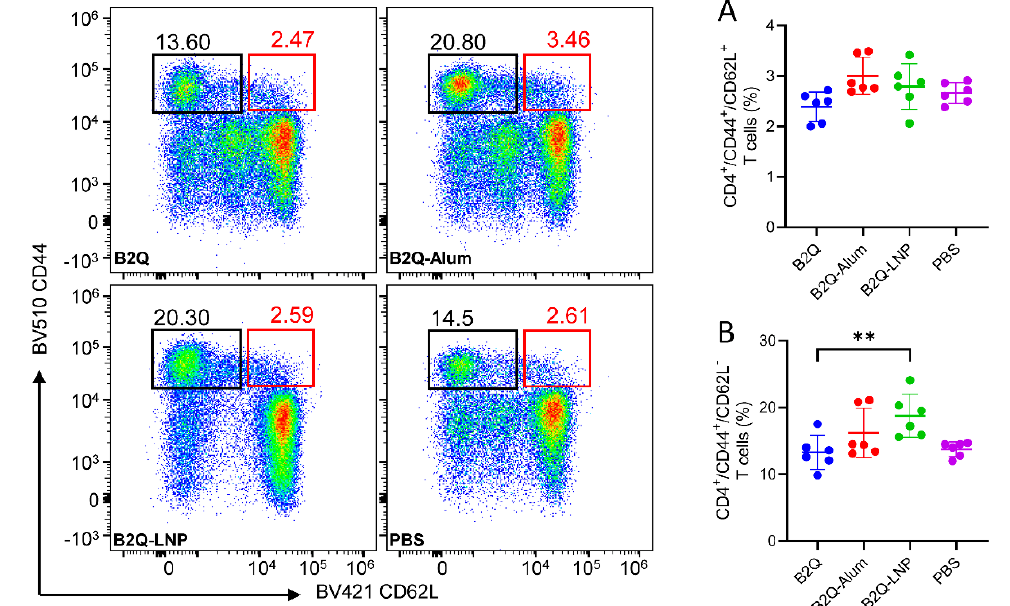
Figure 8. Flow cytometry assay assessing gE-specific CD4 + memory T cells in the LNP encapsulation study. Splenocytes from immunized mice were treated with 10 µg/mL protein gE, and after blocking with brefeldin A, memory CD4 + T cells were detected by CD44+/CD62L+ gating. ( A ) Proportion of central memory T cells. ( B ) Proportion of effector memory T cells. Pseudocolor images displaying representative results near the average value are presented in the left panel. N=6, points represent individual mice. Data are shown as the mean and SD and were analyzed by ANOVA, with the mean of the B2Q-LNP group used as a control. ** p ≤ 0.01.